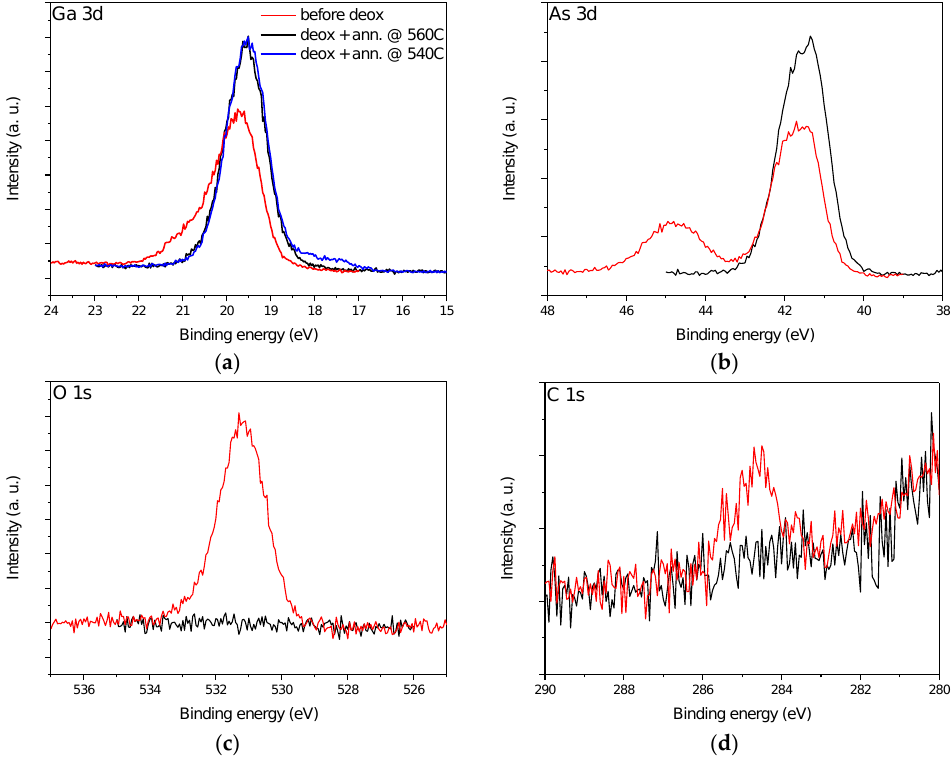
Figure 4. XPS spectra of ( a ) Ga 3d; ( b ) As 3d; ( c ) O 1s and ( d ) C 1s core level emissions before oxide removal (red traces) and after In-assisted oxide removal and annealing at 560 °C (black traces) and 540 °C (blue trace, Ga 3d only).